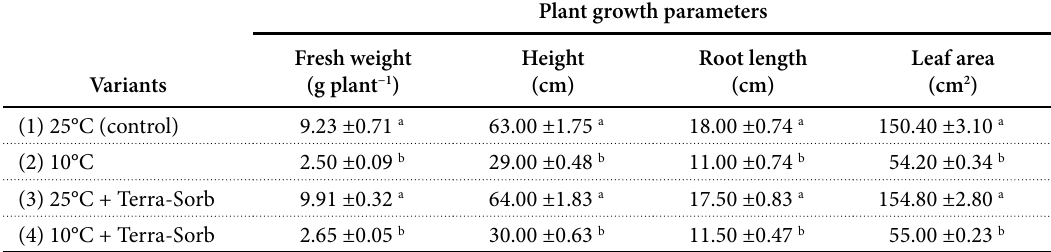
The data presented are sample means ± SD . Different letters (a and b) following the SD values indicate significant differences at p < 0.05.